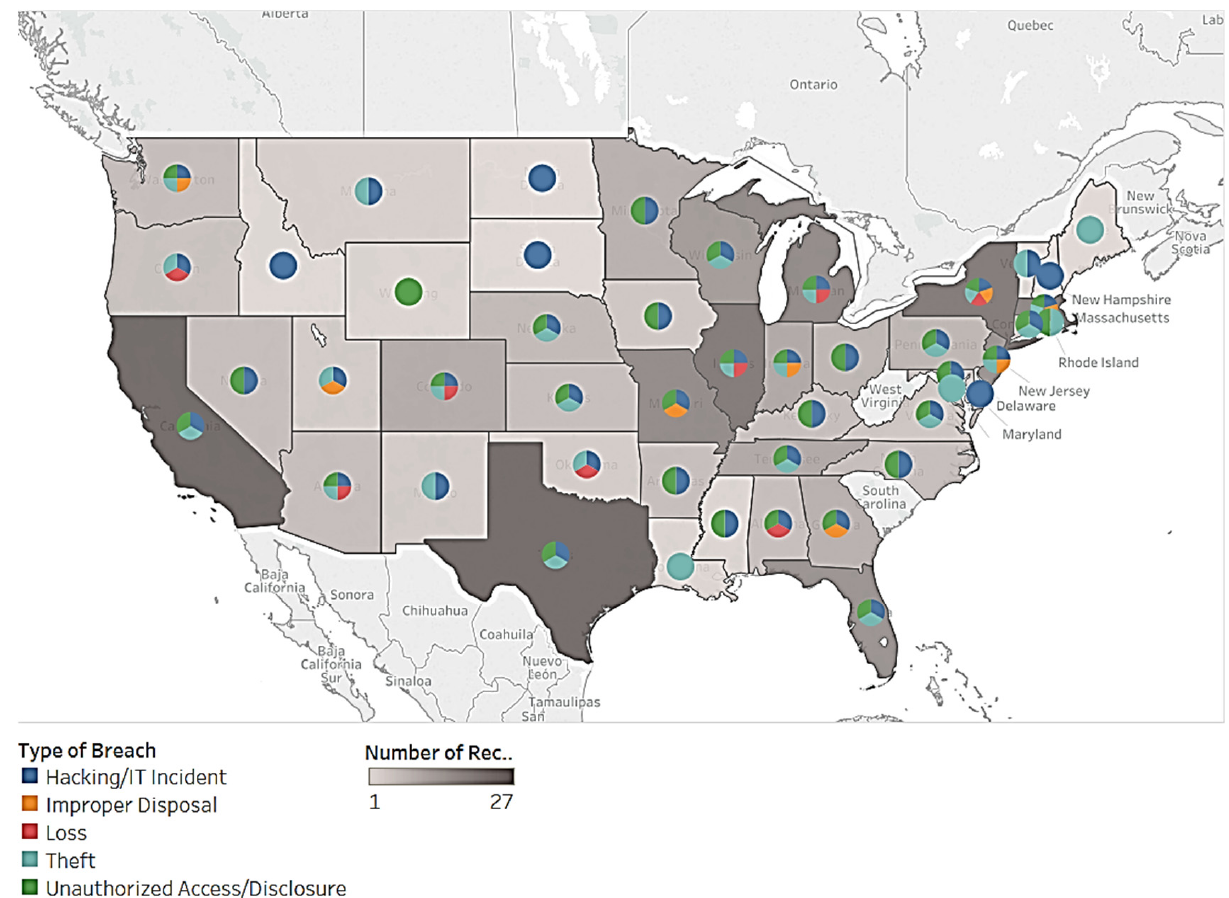
Figure 20. Number of healthcare data breaches by state.